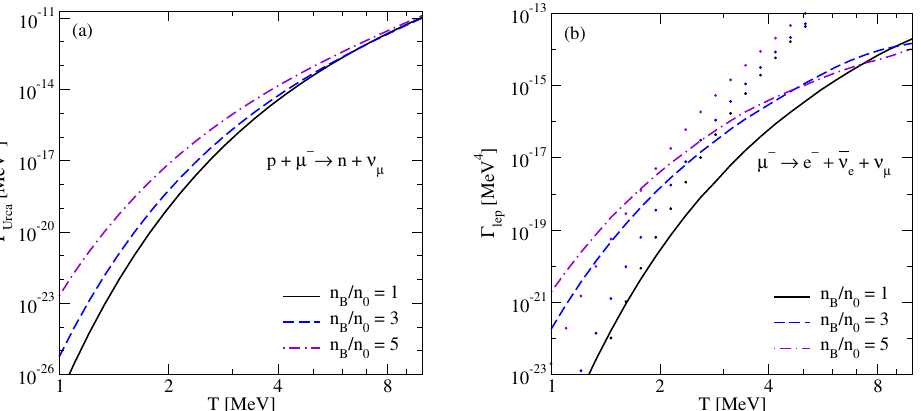
Figure 3. The rates of muon capture ( a ) and muon decay ( b ) processes as functions of the temperature for various densities for neutrino-transparent matter. The neutron µ -decay rate is strongly damped as compared to the muon capture rate. The dotted lines in panel ( b ) show the muon capture rates. Panel (b) of Figure 3 shows the rate of the muon decay (3). The muon decay